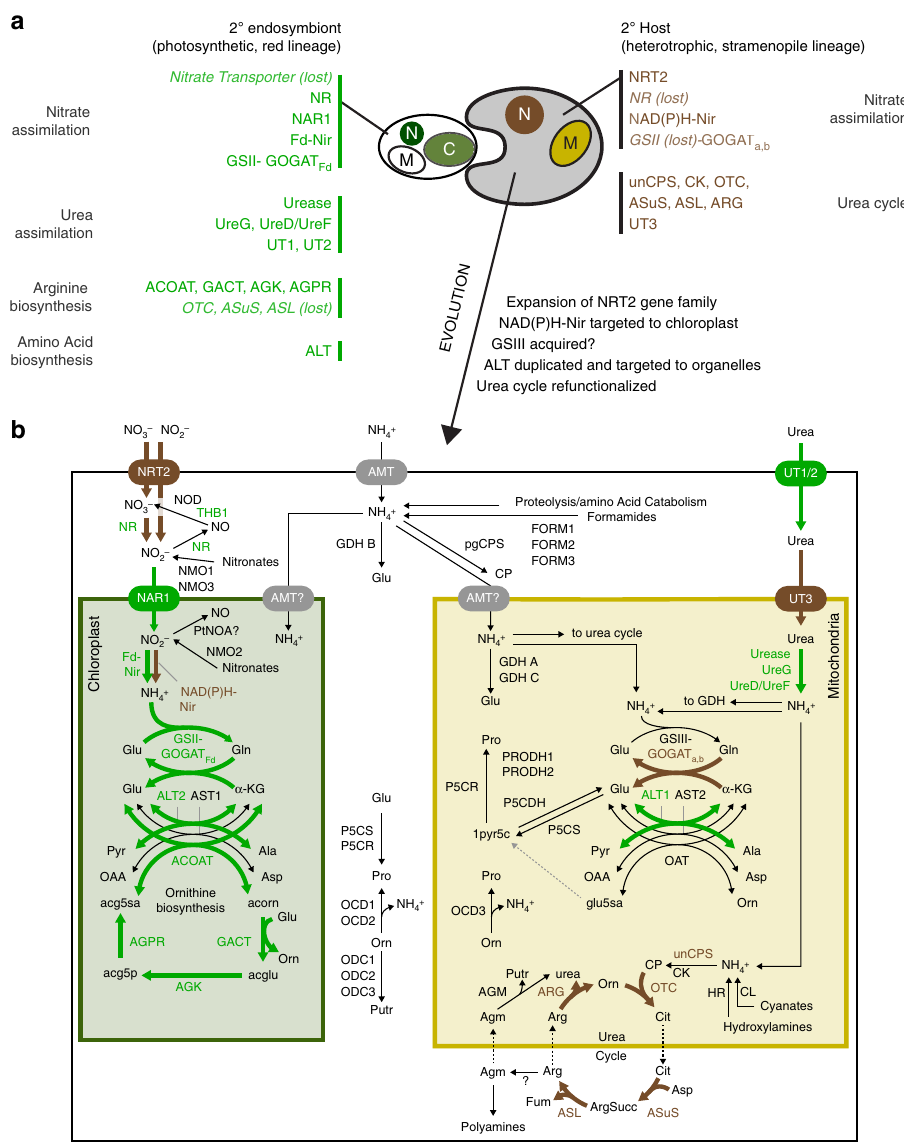
Fig. 4 Model of primary nitrogen assimilation and evolution in P. tricornutum . a Putative origins of nitrogen metabolic genes in extant diatoms identifying components contributed by the endosymbiont or host. b Schematic of compartmentation of major nitrogen assimilation, turnover, and links between the connected pathways. Abbreviated gene names are shown in bold; full names and accessions can be found in Supplementary Data